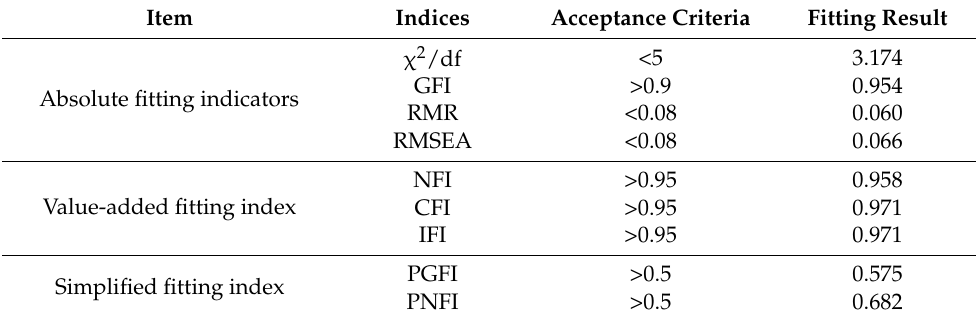
Table 4. Fitting optimization index of